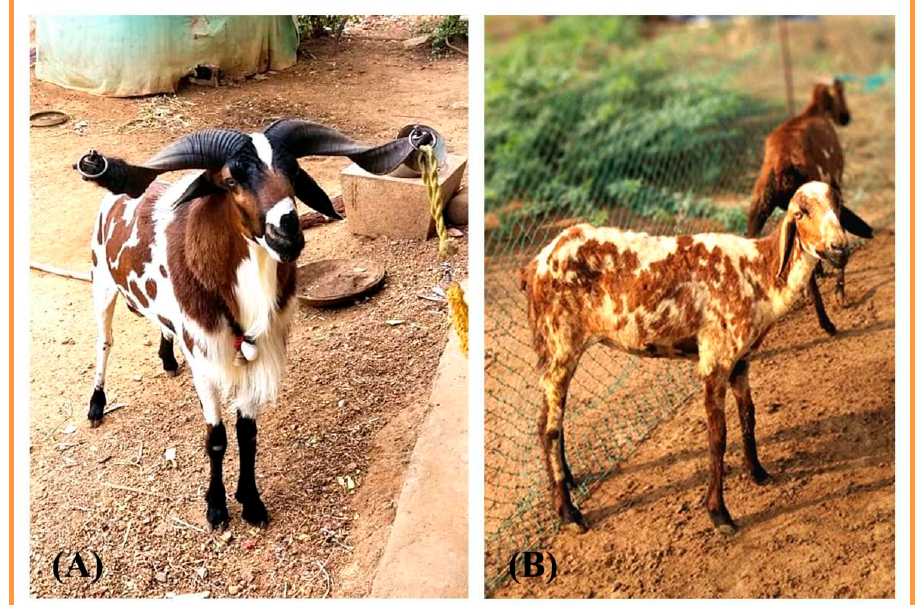
Figure 1. Vembur sheep: ( A ) male; ( B )